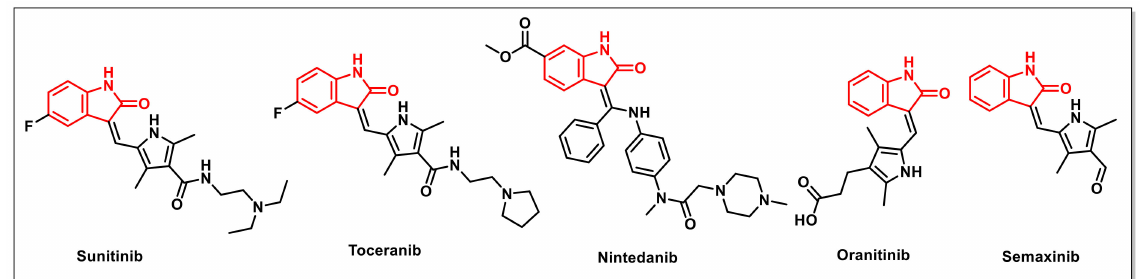
Figure 1. Structures of isatin derivatives approved as drugs or in clinical